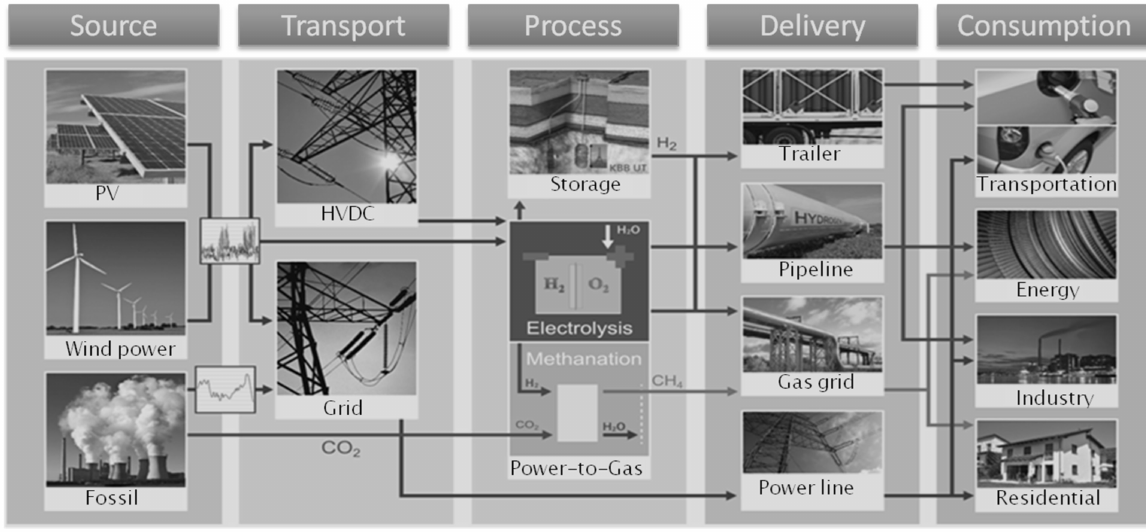
Figure 2. Typical energy economy chain from generation through regenerative resources to